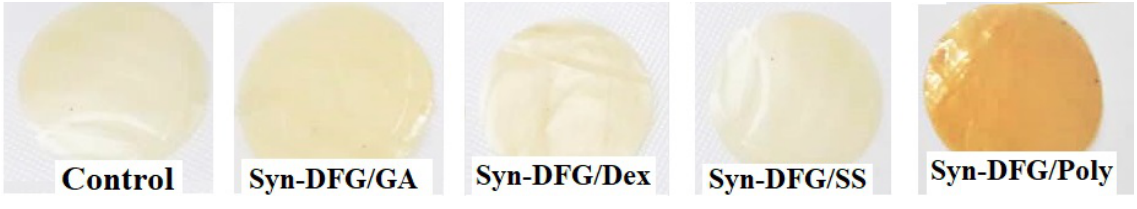
Figure 2. Appearance of probiotic and synbiotic films. Duck feet gelatin, Dex: Dextrin, GA: gum Arabic, Poly: polydextrose, SS: sago starch.